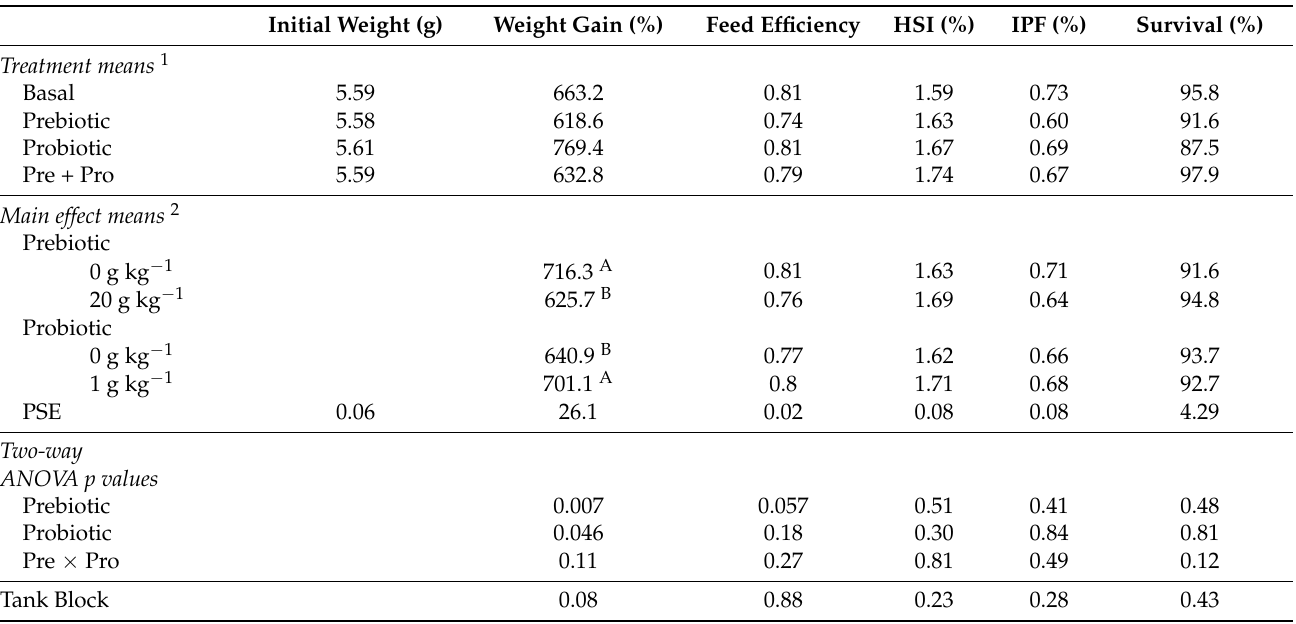
Table 2. Production performance and condition indices of red drum fed probiotic, prebiotic, and their combination for 8